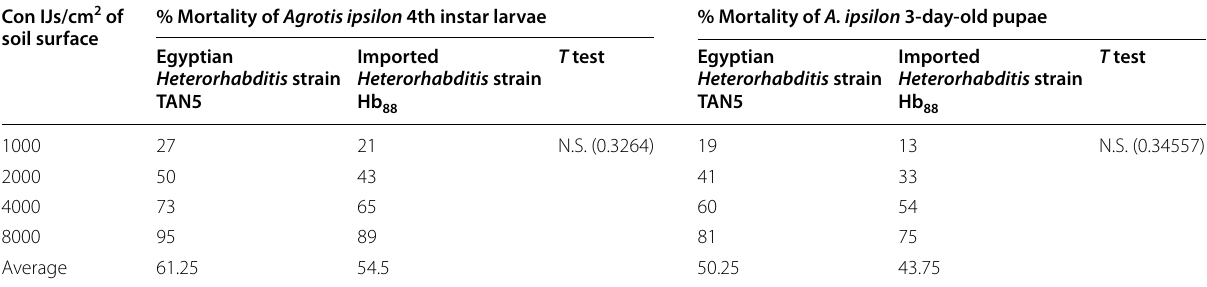
Table 3 Mortality percentages of Agrotis ipsilon (4th instar larvae and 3-day-old pupae) at different concentrations of Heterorhabditis strains TAN5 and Hb in the semi-field application at 25°C and water content in the soil 20% 88 Con IJs/cm 2 of soil